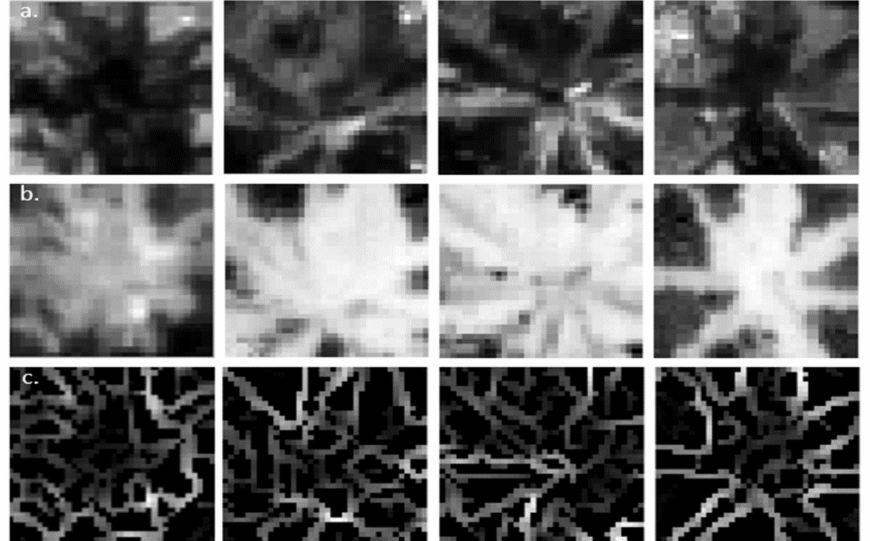
Figure 4. Examples of training samples of banana crowns based on a 36 × 36 pixel window showing four examples in each row for the ( a ) green band, ( b ) near-infrared band, and ( c ) Canny edge-detection algorithm based on the Enhanced Vegetation Index 2